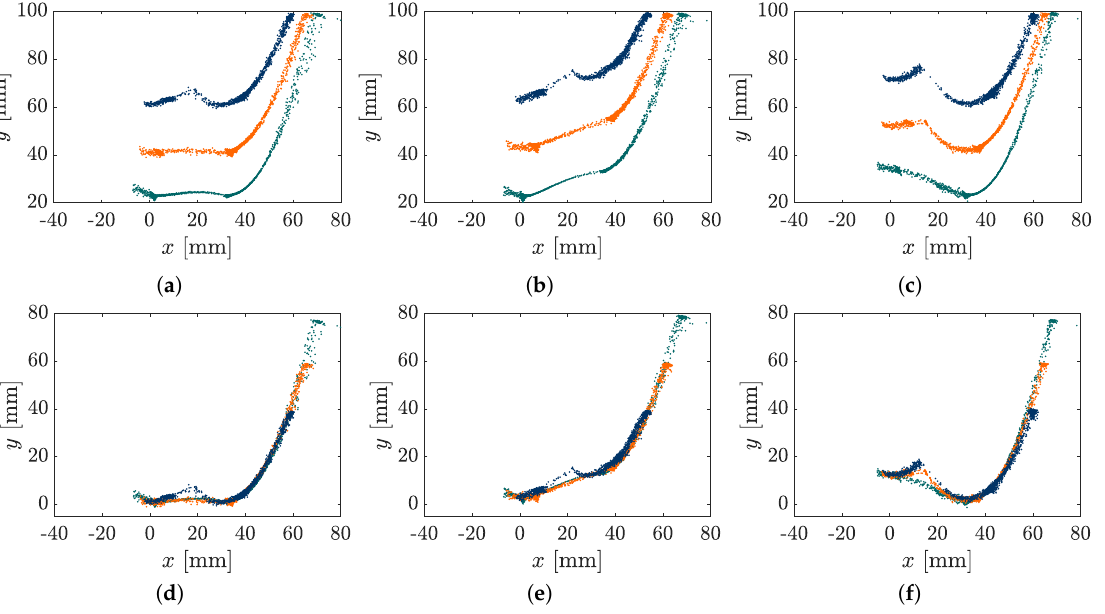
Figure 9. Contour reconstruction of objects O1 ( a , d ), O2 ( b , e ) and O3 ( c , f ) for different object distances q = 20 mm (green), q = 40 mm (orange), q = 60 mm ( blue ) ( a – c ) and excluding the distance offset ( d – f